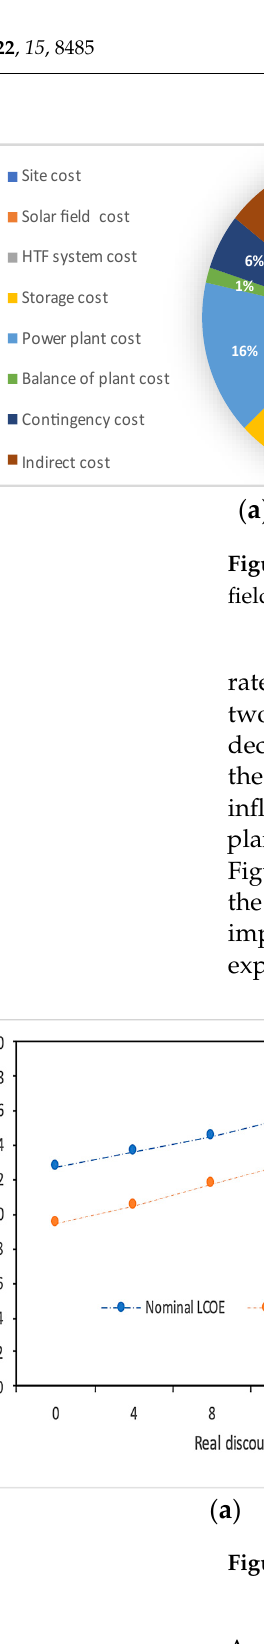
Figure 12. Effects of financial parameter uncertainties on LCOEs: ( a ) real LCOE and ( b ) nominal LCOE .